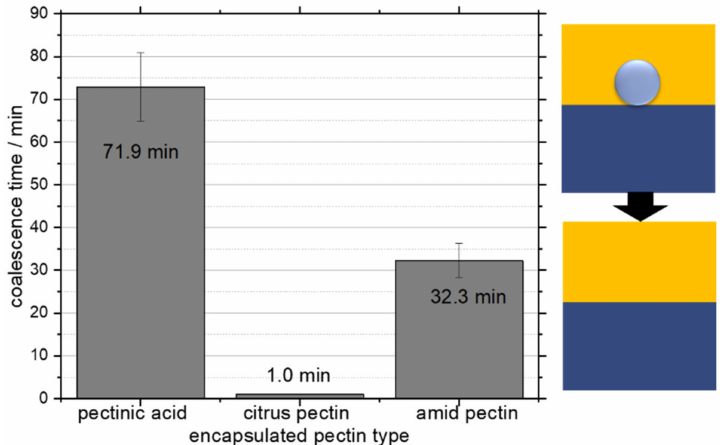
Figure 12. Coalescence time depends on the molecular structure of the encapsulated pectin. The interfaces are stabilized with Lutensol TO8 (O / W2) and PGPR (W1 / O). The mean values of eight single 2 µ L drops measured in succession are given.